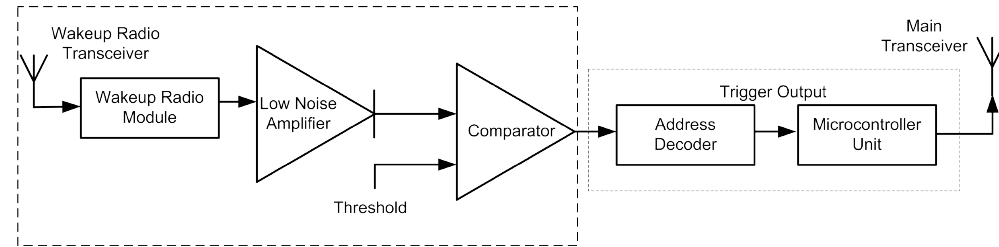
Figure 4. Example of the wake up radio architecture.